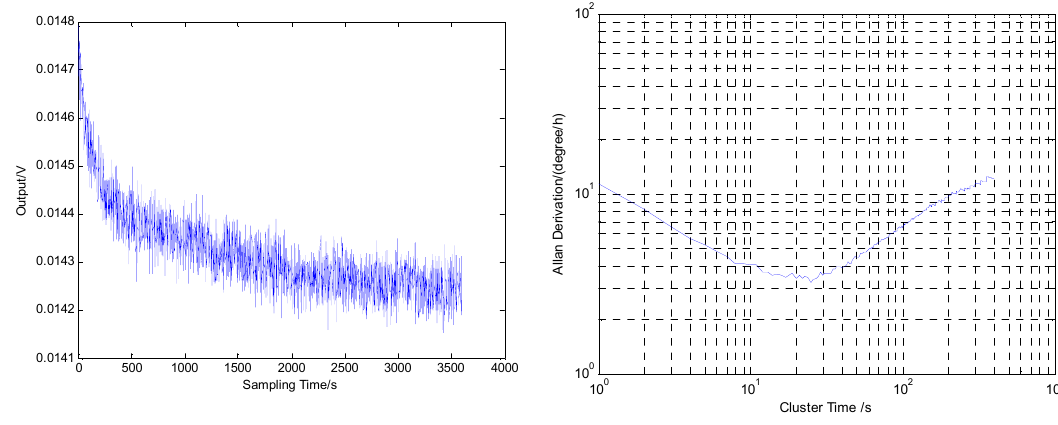
Figure 7. Output signal and Allan derivation of the output signal.